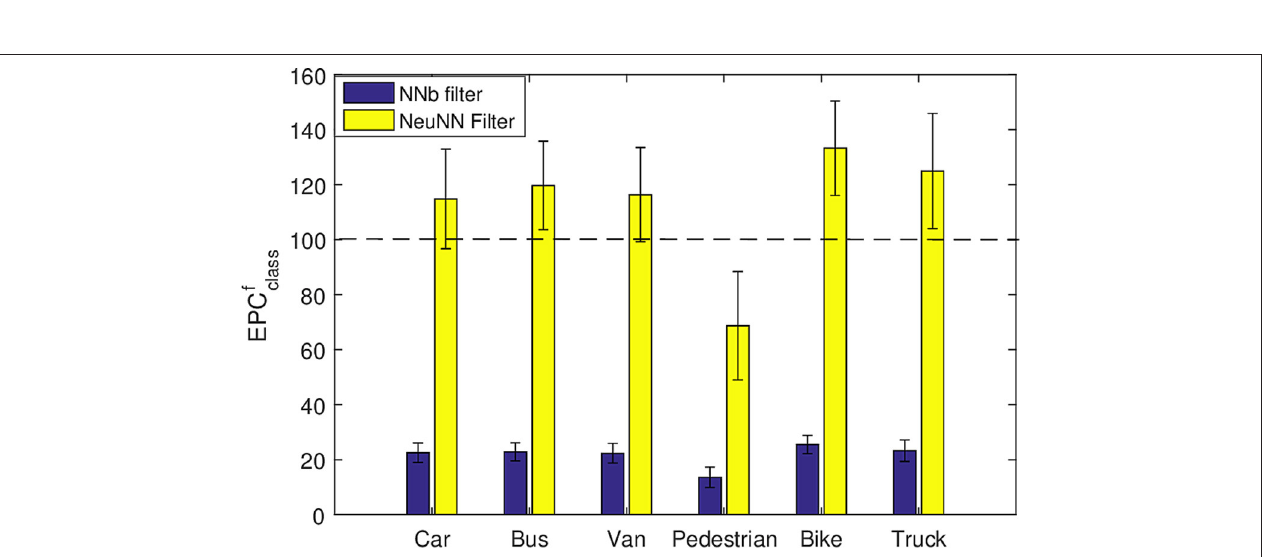
Frontiers in Neuroscience |